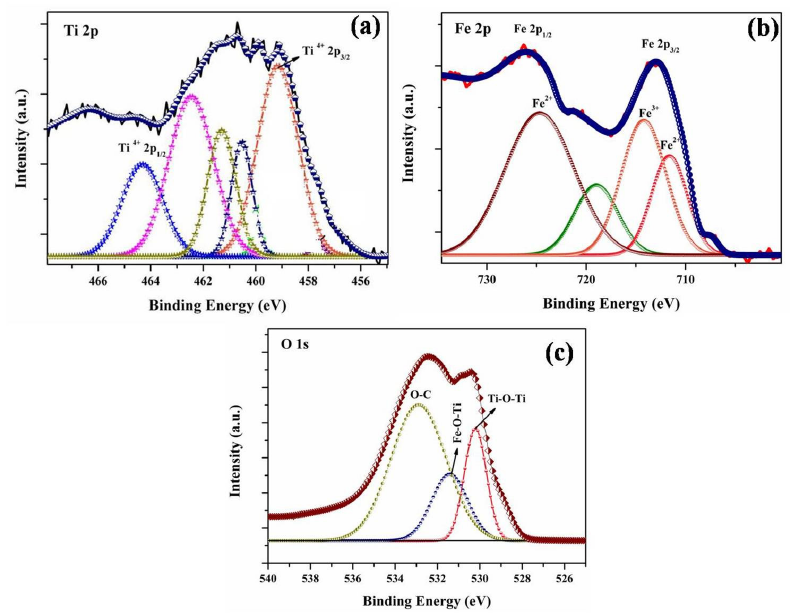
Figure 2. Represents high resolution XPS spectra of ( a ) Ti2p, ( b ) Fe2p and ( c ) O1s of FeTiO 3 perov- skite.